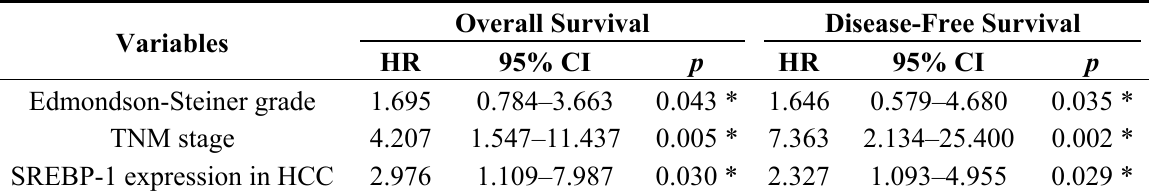
Table 2. Multivariate Cox regression analysis of 3-year OS and DFS of 47 HCC